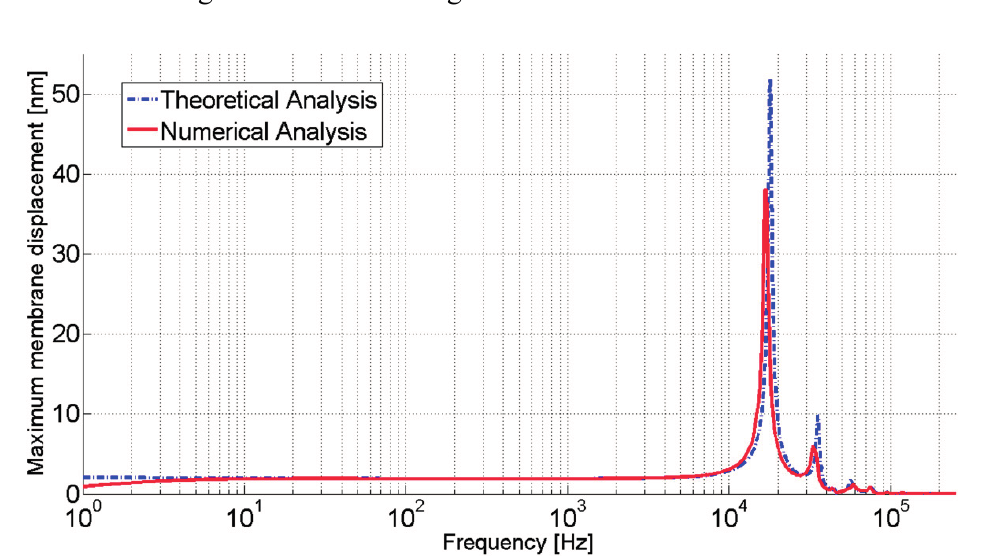
= 5 mm, (cid:1844) = 0.75 mm, ℎ = 3000 µm, ℎ g = 30 µm, (cid:3040) (cid:3029) (cid:3030) = 8 (cid:3040)